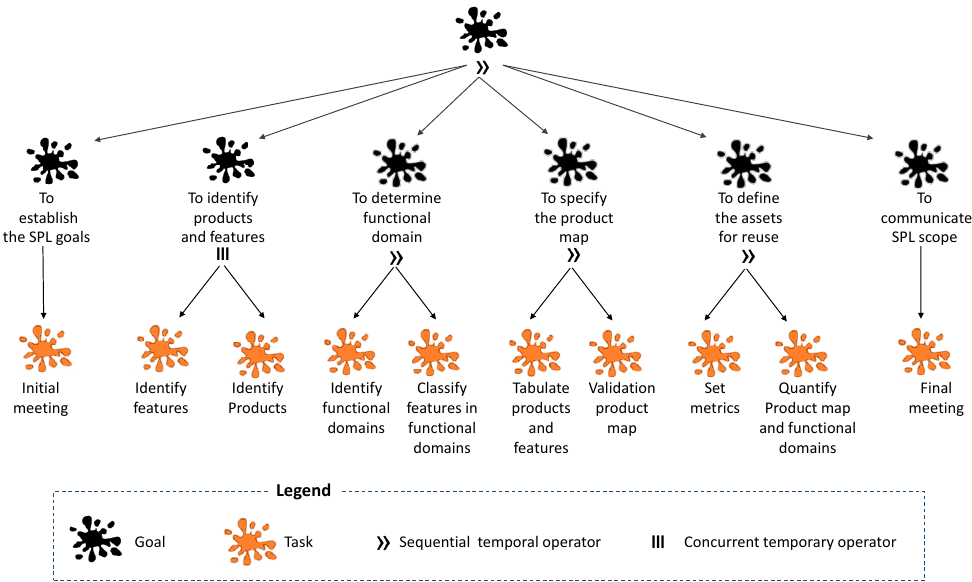
Figure 1. Hierarchical structure of CoMeS-SPL (Collaborative Method for Scoping an